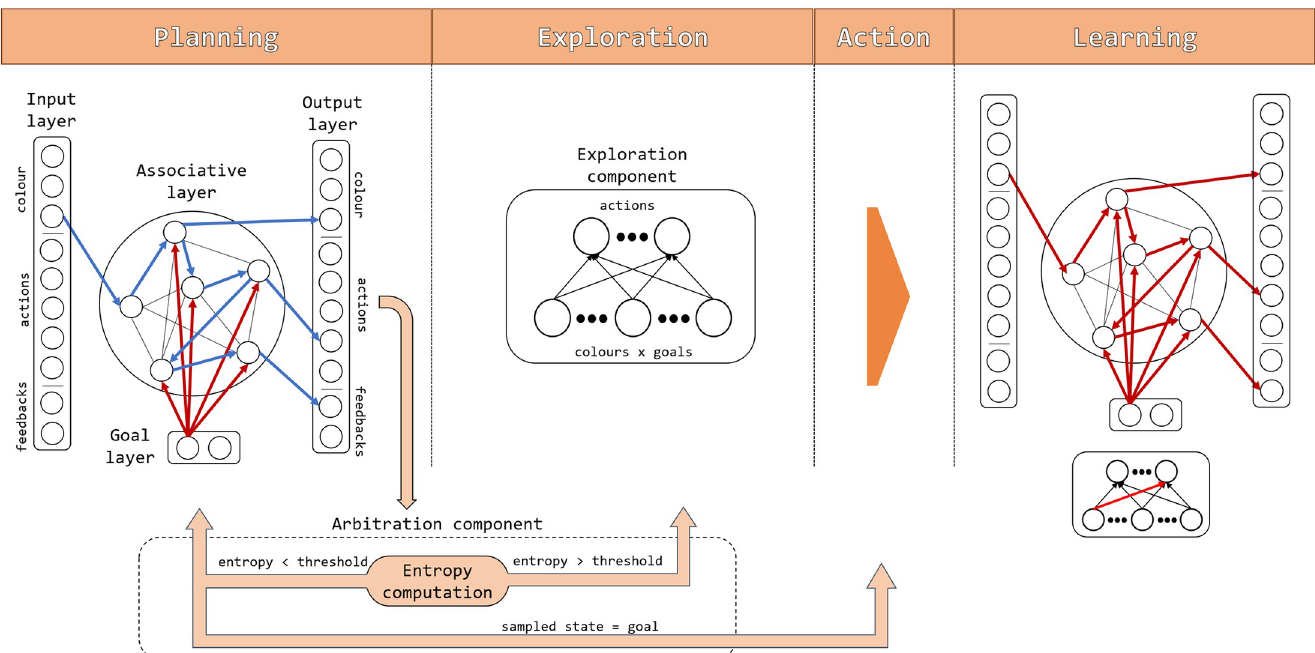
Fig 2. Architecture and functioning of the model: Components and information flow. The architecture is formed by a planning component (representing input patterns, hidden causes of input patterns within an associative layer, expected events including actions, and goals), an exploration component selecting actions when planning is uncertain, and an arbitration component deciding when to plan, explore, or act. The figure also shows the timing of the processes taking place during a trial, with the first two left graphs showing the Planning (exploitation) and (possibly) Exploration phases and the right two graphs showing the Action execution and Learning phases. Blue arrows represent an example of information flow travelling stable connections during the Planning phase and red arrows represent information flows travelling connections that are updated during the Learning phase.